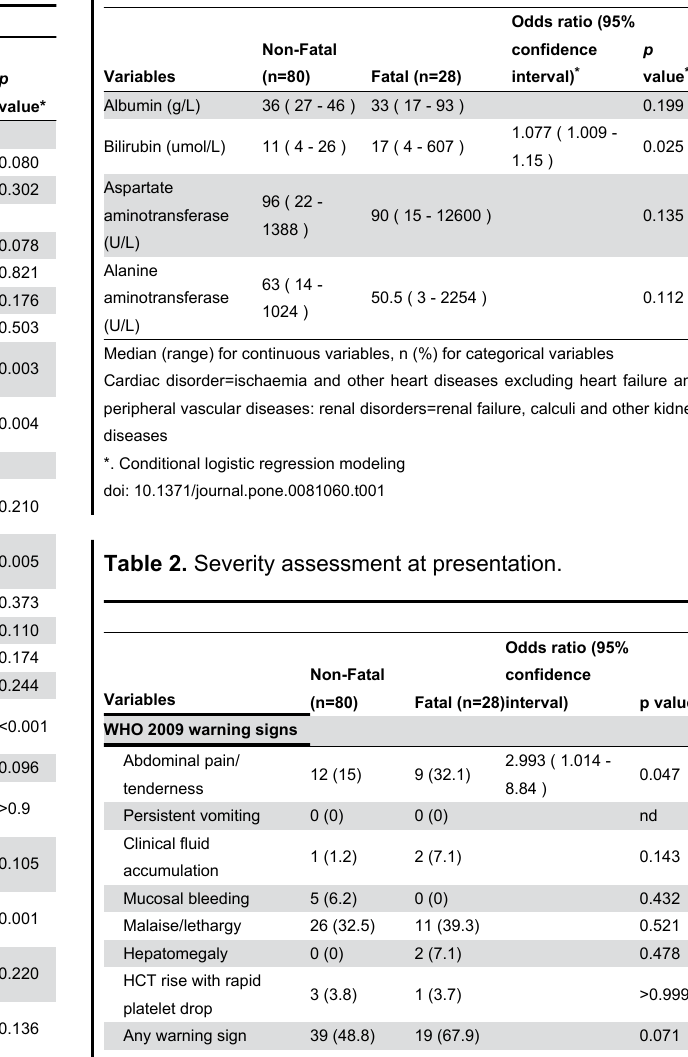
Table 1. Characteristics of patients and clinical manifestations at the time of hospital presentation.